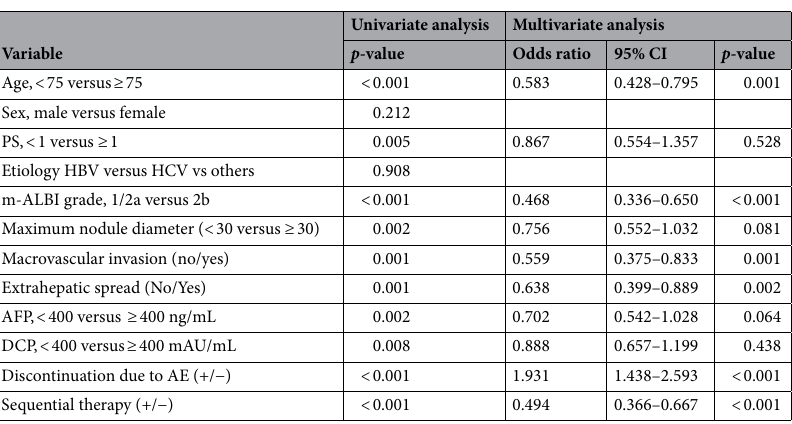
Univariate analysis Multivariate